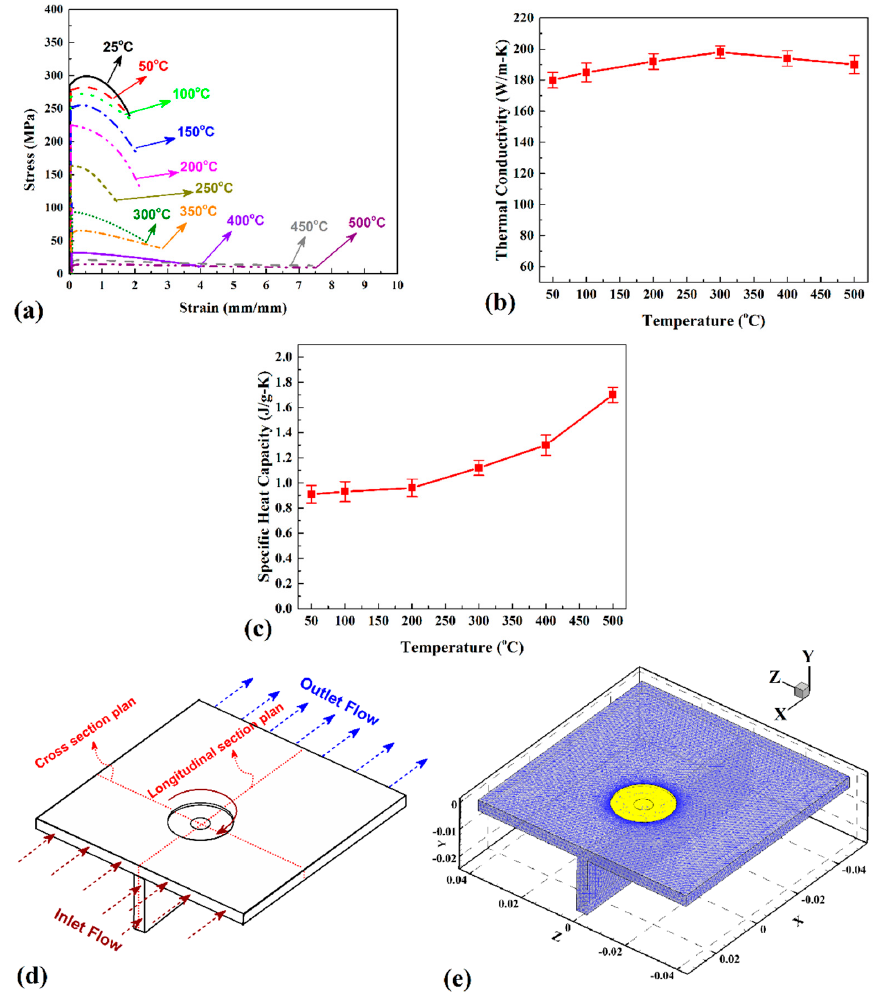
Figure 2. ( a ) Stress–strain graph of AA6068 aluminum alloy at various temperatures. ( b ) Thermal conductivity and ( c ) specific heat of AA6068 aluminum alloy at various temperatures. ( d ) Simulation domain and ( e ) meshed domain.